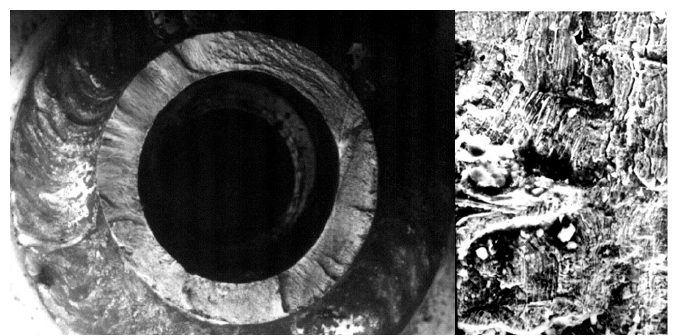
Figure 5. The fractured edge of the blowdown pipe.